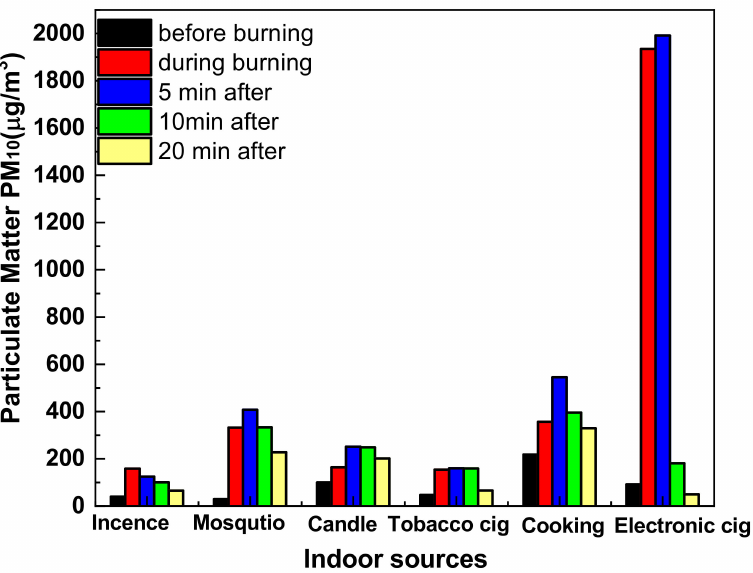
Figure 6. Particulate matter mass concentration (PM 10 ) for six indoor aerosol sources (incense, mosquito coils, candles, tobacco cigarettes, cooking and electronic cigarettes) at different times (before being turned on, during operation and after being